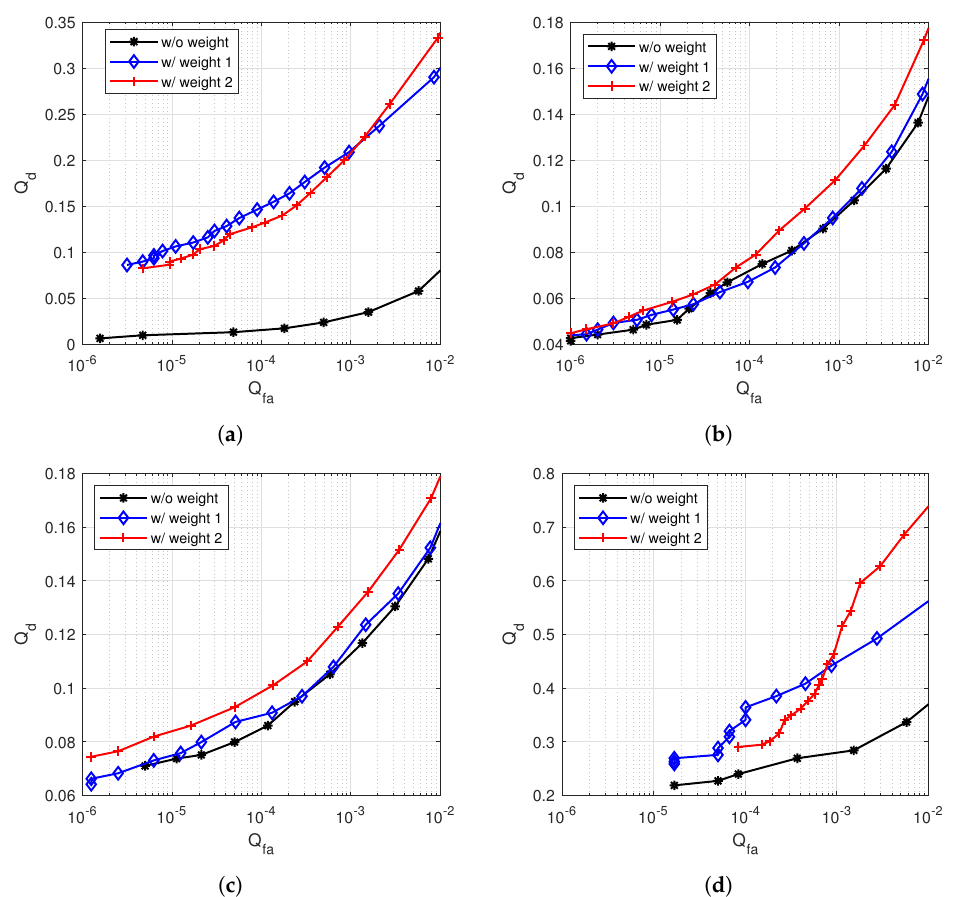
Figure 4. Curves of Q d − Q fa obtained from four experiments. ( a ) Experiment 1; ( b ) experiment 2; ( c ) experiment 3; ( d ) experiment